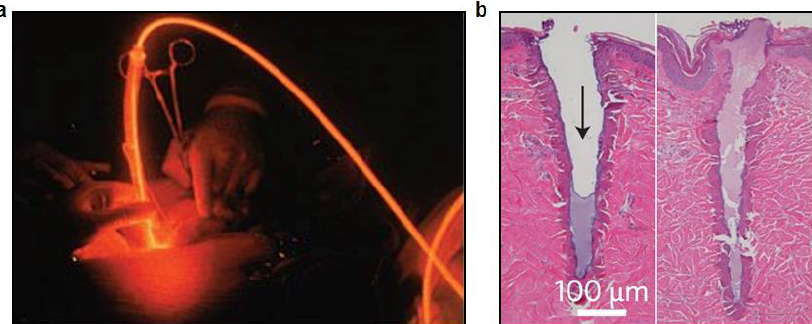
Figure 9. Applications in phototherapy and surgery. ( a ) An example of photodynamic therapy. Reproduced with permission [81]. National Cancer Institute. ( b ) An example of application of light in surgery. Reproduced with permission [1]. Copyright 2017, Nature Publishing Group.